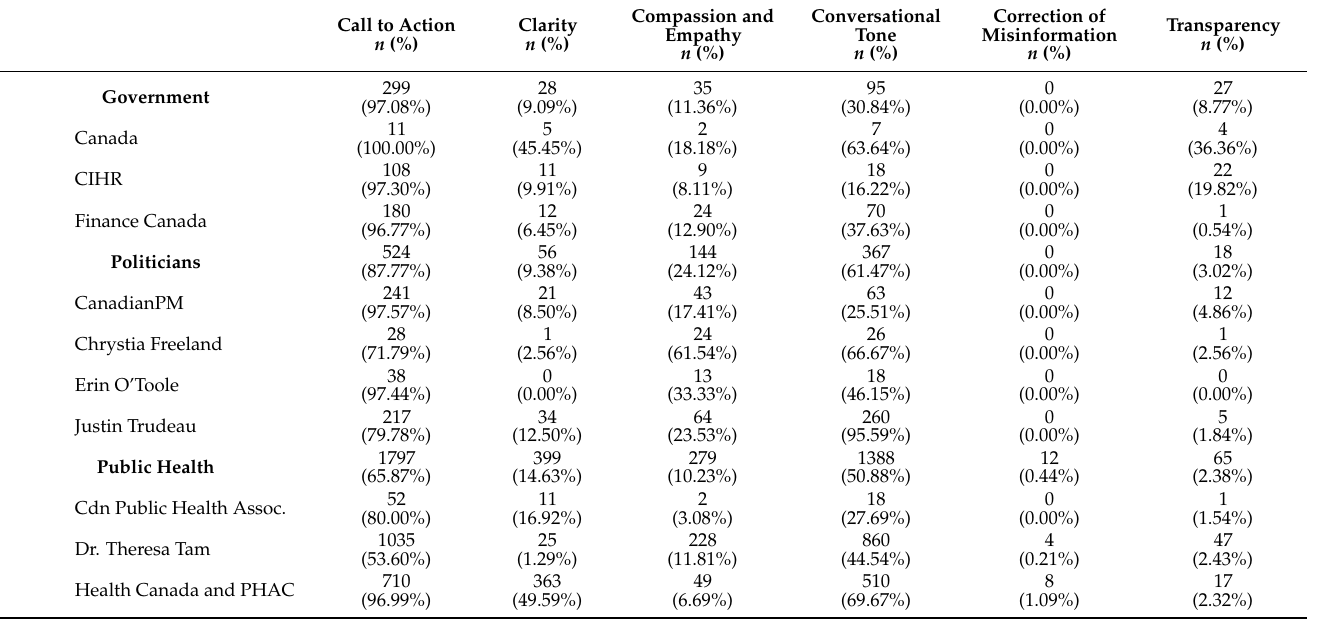
Table 3. Guiding principles that were used in tweets from government, politician, and public health Twitter